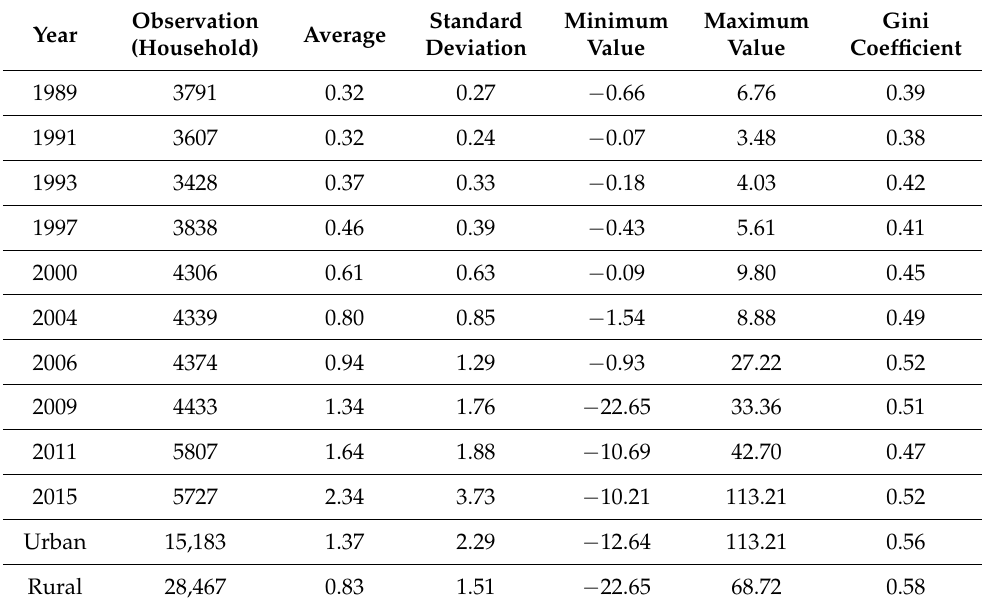
Table 1. Descriptive statistics of per capita annual income of families (ten thousand